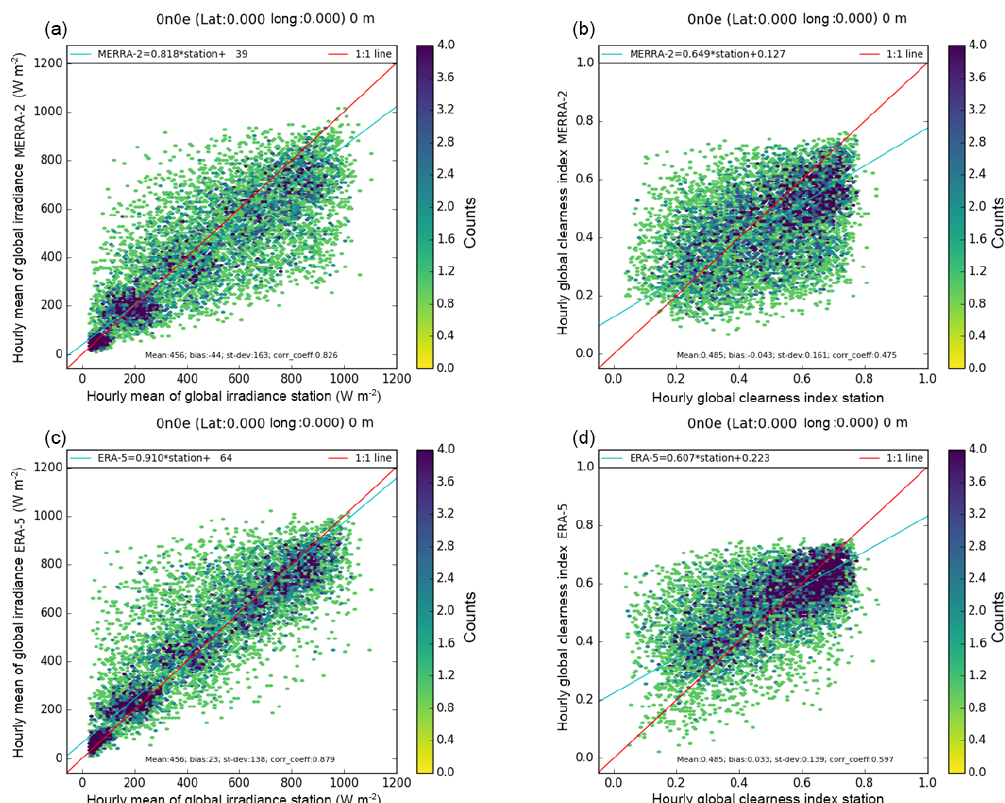
Figure A4. The 2-D histograms of PIRATA measurements (horizontal axis) and data sets (vertical axis) at 0 ◦ N, 0 ◦ E for E and KT. MERRA- 2: (a) and (b) ; ERA5: (c) and (d) . Ideally, the dots should lie along the red line (1:1 line). The blue line is the affine function fitted over the points and should ideally overlay the red line.